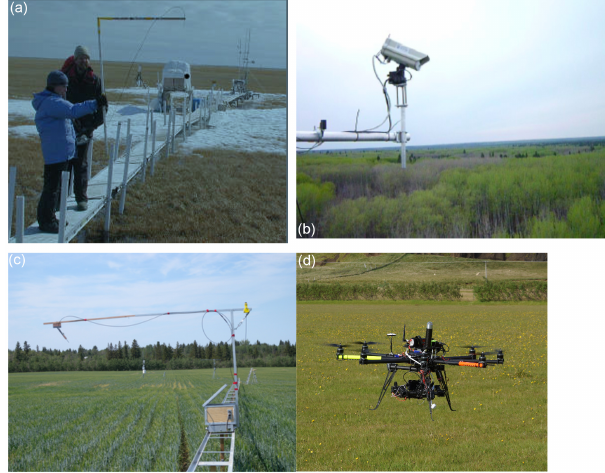
Figure 6. Optical sampling methods applied to spatially extensive sampling within flux tower footprint. (a) Hand sampling along a boardwalk leading to a flux tower, (b) automated sampling with an automated spectrometer (“AMSPEC”) and webcam mounted on a flux tower (adapted from Hilker et al., 2010; Hilker et al., 2011), (c) automated sampling with a tram, a motorized cart on a track, and (d) airborne sampling with an octocopter drone (photo cour- tesy Richard Streeter and Alasdair Mac Arthur). (a–c) depict the “UniSpec DC” (PP Systems, Amesbury MA), a dual detector in- strument that can be configured for manual or automatic sampling from a variety of platforms. The “Cinestar 8” drone (d) carries a dual field-of-view VNIR “Piccolo” spectrometer (developed by Alasdair MacArthur NERC FSF), comprised of a spectral detector (USB 2000, Ocean Optics, Dunedin FL, USA) with a shuttered, bi- furcated fiber providing alternate upward and downward sampling. Note that all methods correct for changing sky conditions, either by simultaneous (a–c) , or alternating (d) radiance and irradiance sam- pling, allowing expanded sampling in both space and time to match the scale of eddy covariance